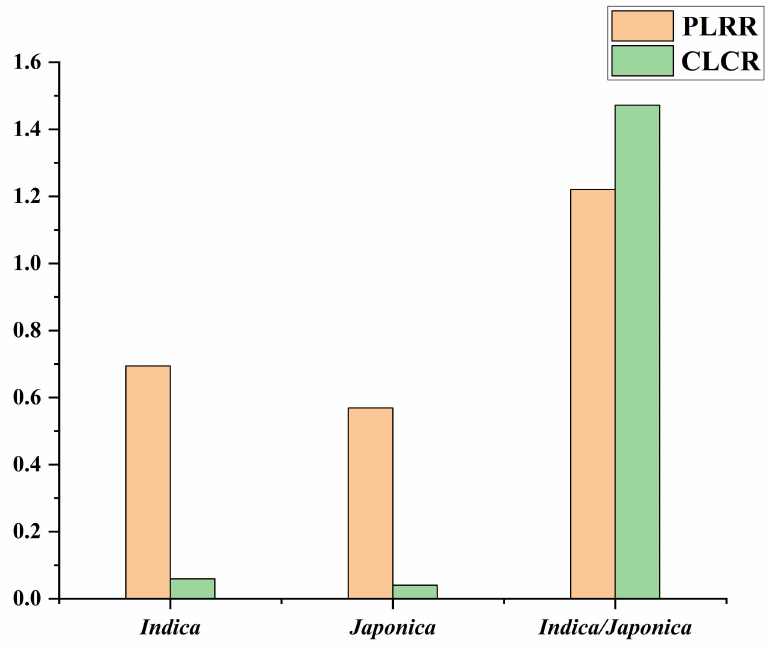
Figure 7. Comparison of PLRR and CLCR (CLC divided by 15) indices among different subgroups. Yellow boxes represent indica , green boxes represent japonica